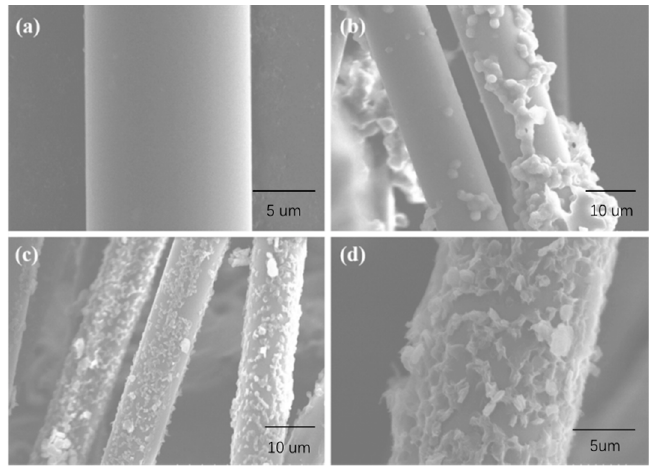
Figure 8. Microstructure of ( a ) untreated PET fiber, ( b ) MPP-modified PET fiber, and ( c ) and ( d ) TMPP-modified PET fiber.